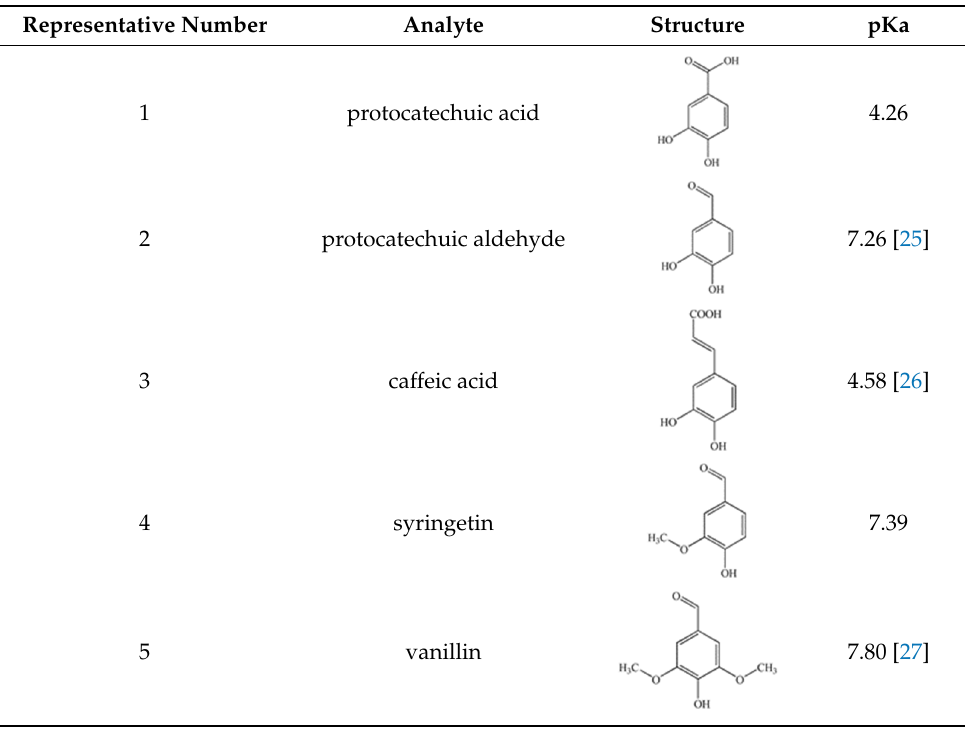
Table 1. Five compounds in Cibotium barometz .